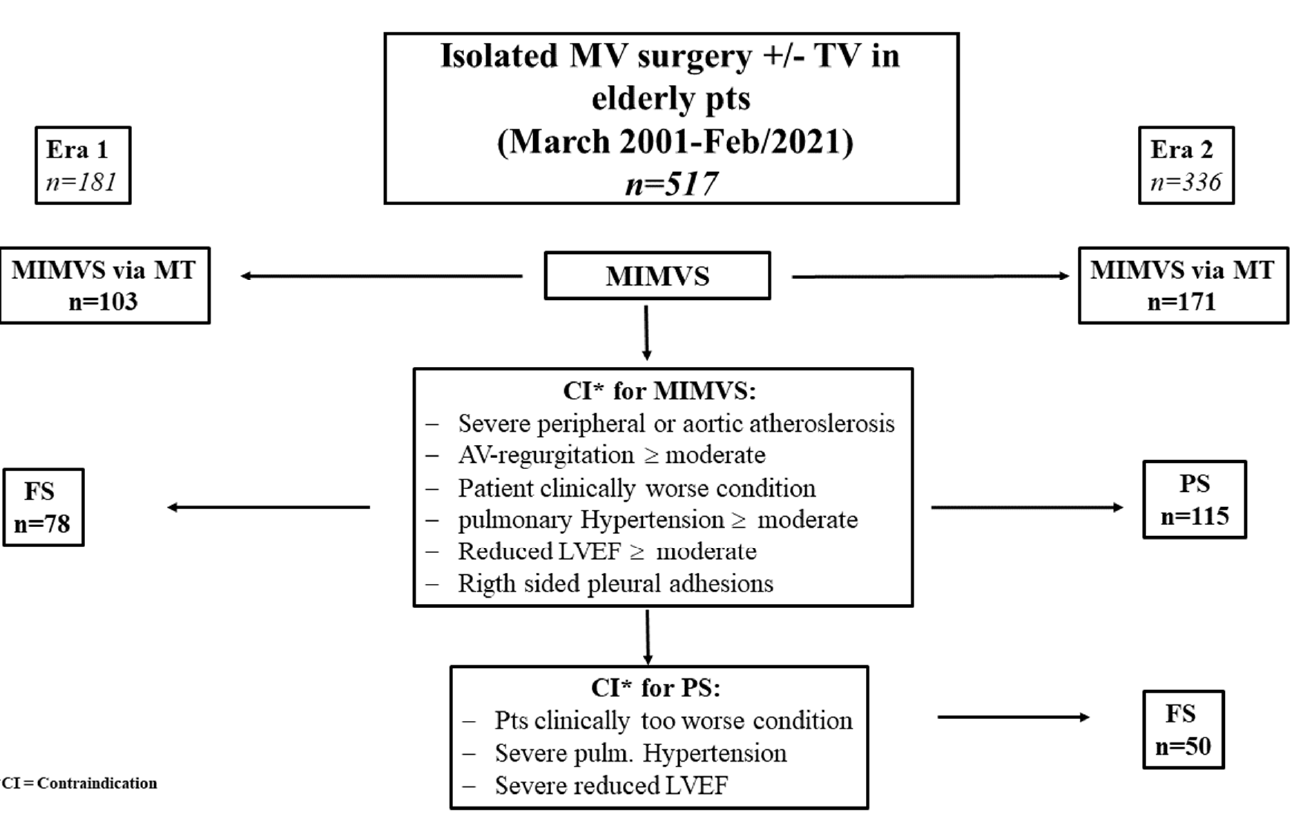
Figure 1. Flowchart for the algorithm of appropriate approach in elderly patients. * CI = contraindication, ± = with or without